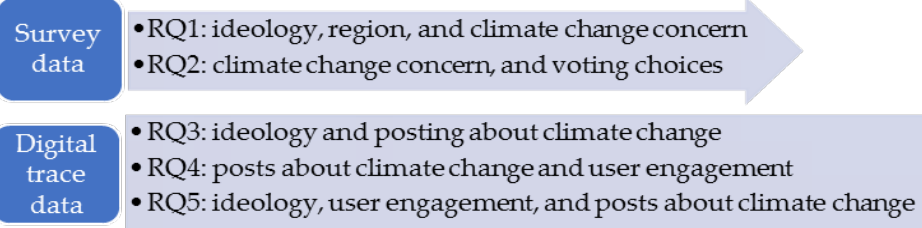
Figure 1. Methodological framework.